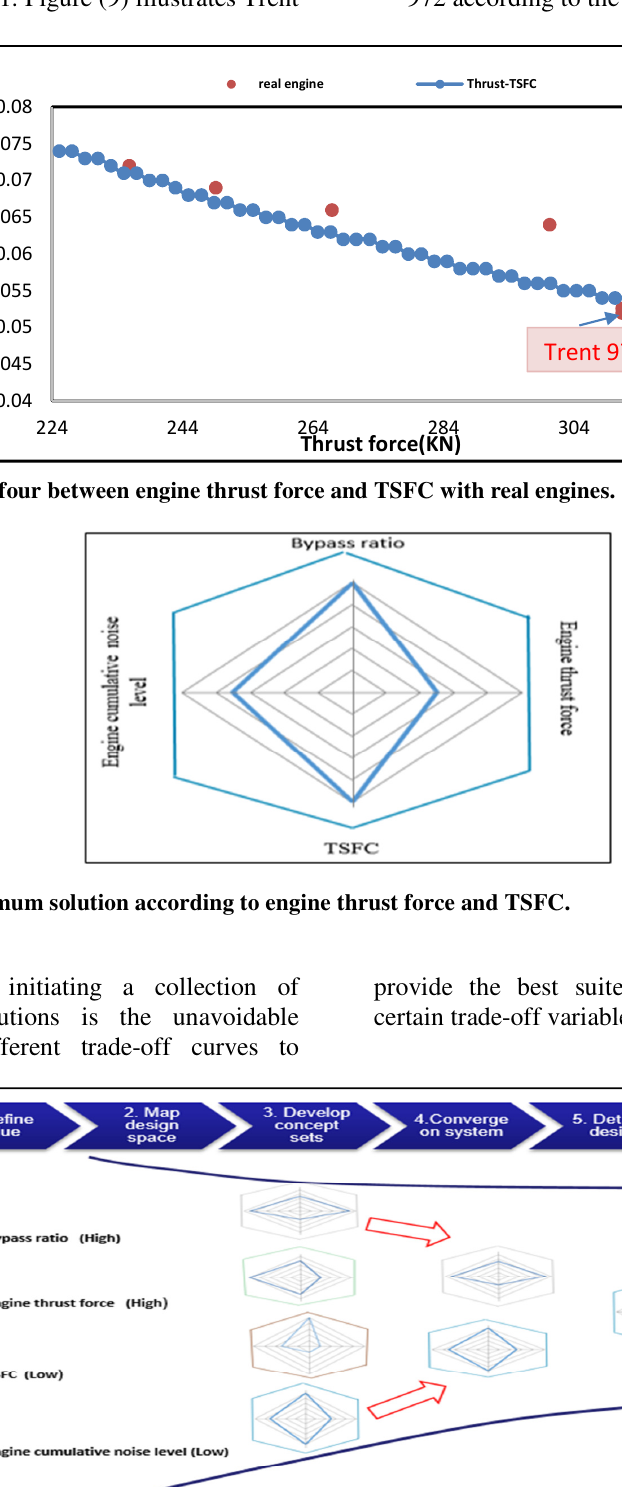
Fig. 10: Mechanism of narrowing set base